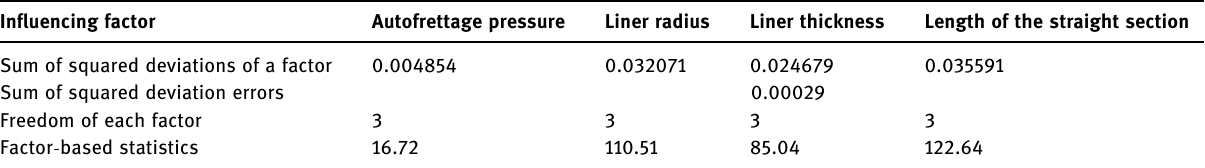
Table 6: Analysis of variance